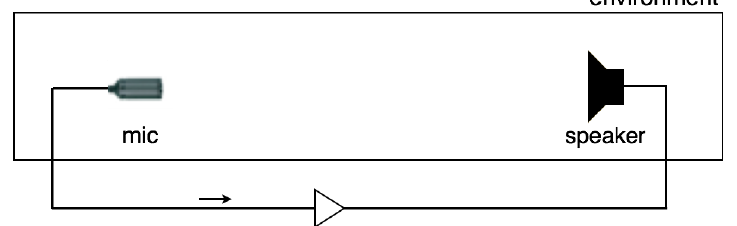
Figure 1. Basic structure for audio feedback. Signals from a microphone are amplified, emitted by a loudspeaker, then received by the microphone again to be endlessly